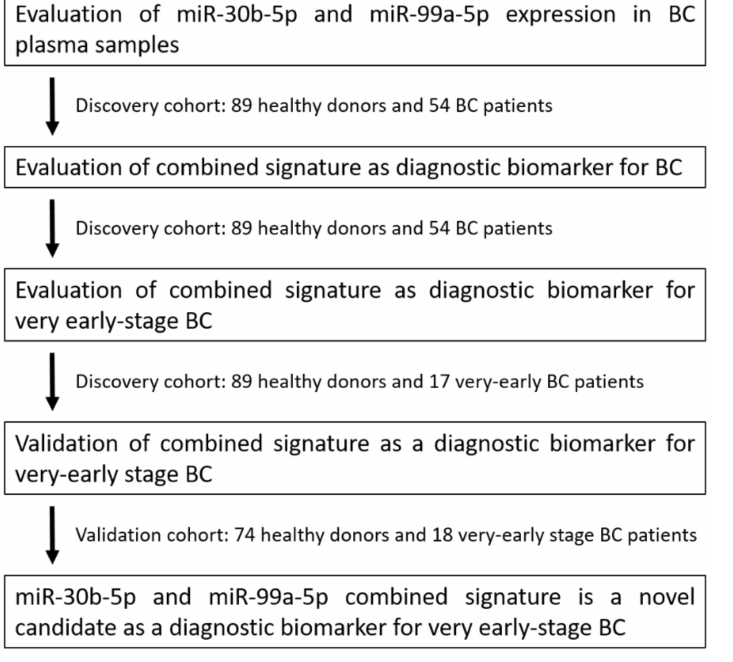
Figure 1. Study design to develop a novel combined miRNA signature biomarker.